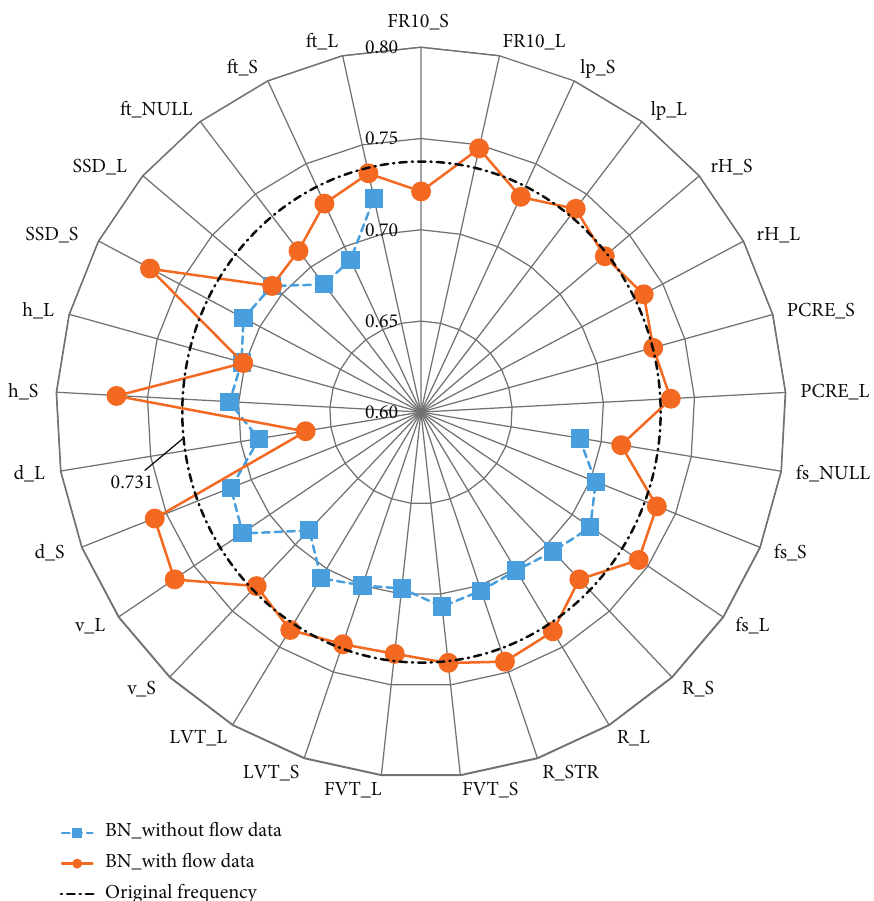
Figure 6: BN probability inference results for variables in varying states of decreasing crash